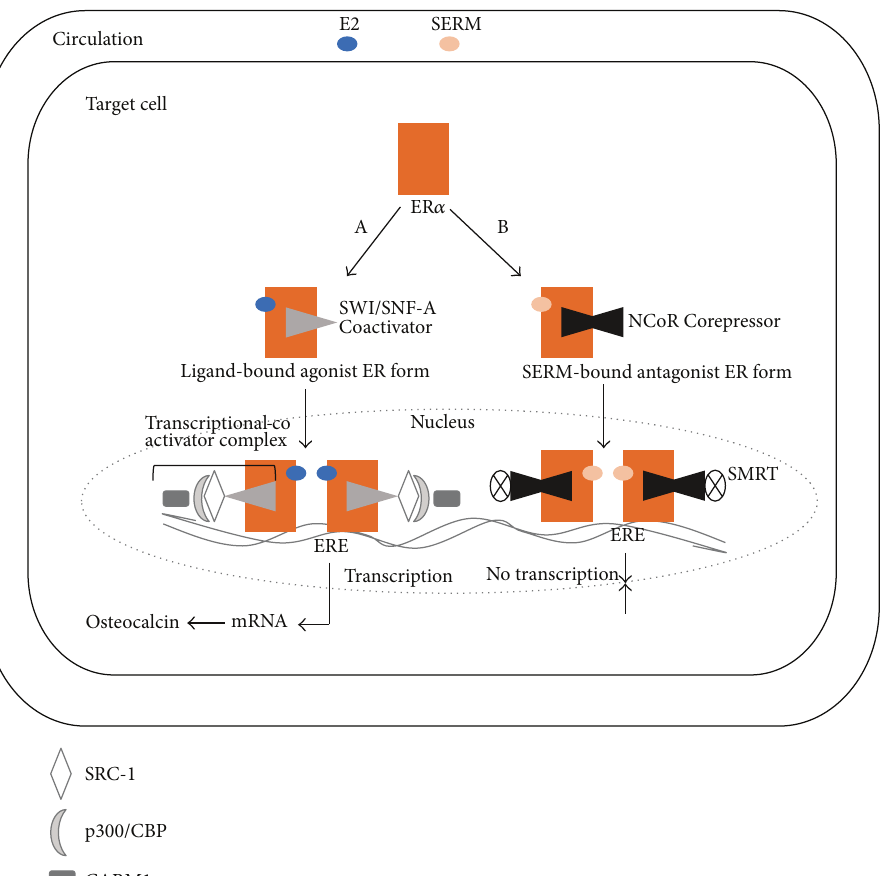
Figure 3: Schematic representation of the genomic effect of estradiol. Nuclear translocation of ligand-bound receptor. (A) Activation of targeted genes in osteoblasts necessitates recruitment of two chromatin remodeling complexes known as SWI/SNF-A (switching defective/sucrose nonfermenting), as well as coactivators of the p160 family including SRC-1, SRC-2, and SRC-3 (steroid receptor coactivators 1, 2, and 3). All of the SRCs possess three nuclear receptor (NR) boxes located in the receptor interacting domain, which enables direct interaction with ER 𝛼 ; and two activation domains, AD1 and AD2, which serve as binding sites for p300/CBP (cointegrator-associated protein), and CARM1 (coactivator-associated arginine methyltransferase 1). The importance of these coregulators, especially p300/CBP, relates to the latter’s interaction with the AF-2 domain of the ERs, which prompts recruitment of histone acetylases to the receptor. Together with the SRC complexes, the epigenetic enzyme disrupts DNA stability, thus allowing transcription of the target genes. (B) Repression of transcription occurs in a manner opposite to that of activation. Upon SERM binding, the receptor undergoes conformational changes that enhance interactions with corepressors. Three of the most well-known repressors of ER 𝛼 -mediated transcriptional activity are NCoR (nuclear corepressor), silencing mediator of retinoid and thyroid receptor (SMRT), and repressor of ER 𝛼 activity (REA). This transcriptional comodulatory apparatus results in inhibition of